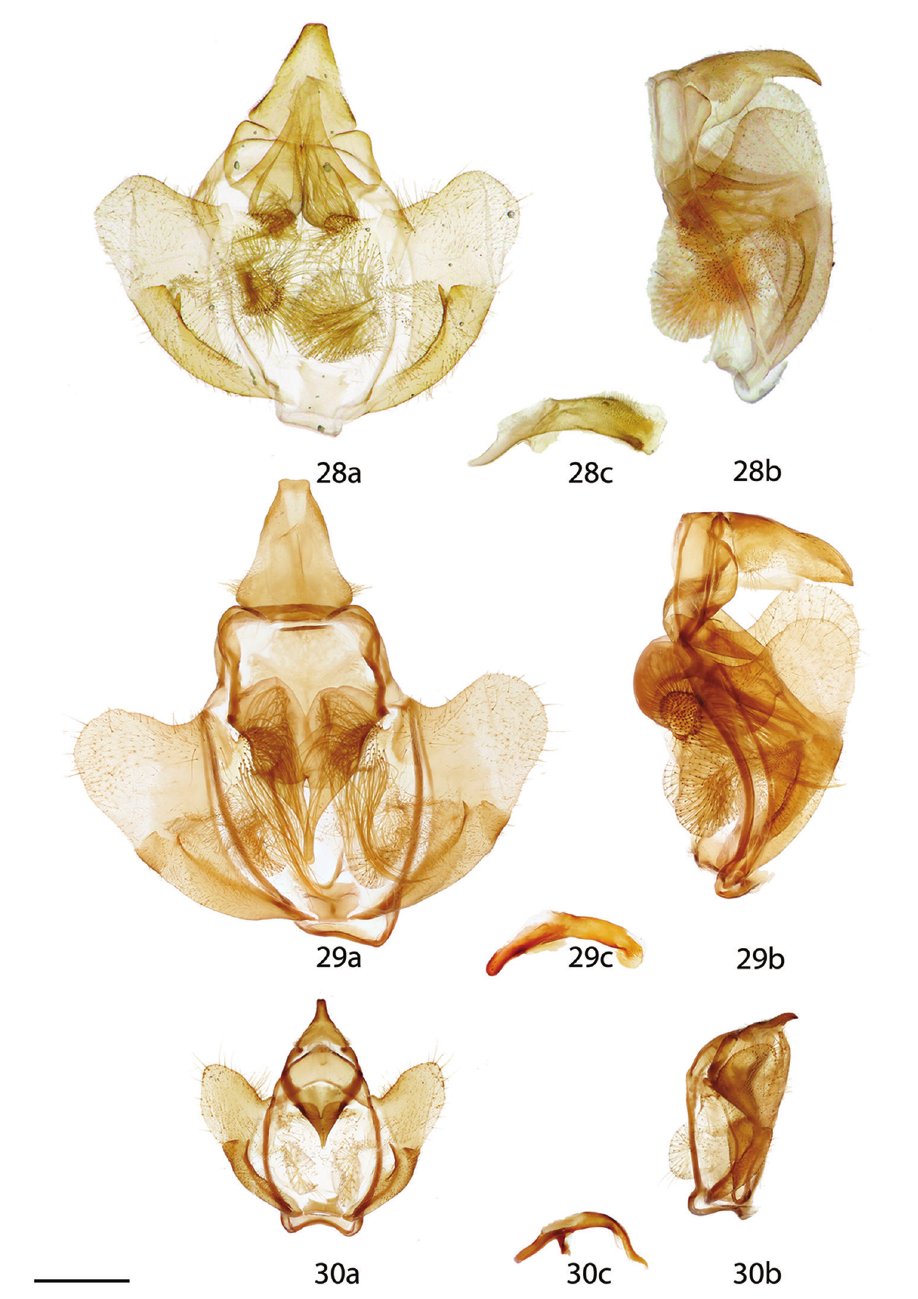
trito Federal, Planaltina, 1000 m, C. Mielke genitalia prep. 6.812 (CPAC) 29 R. minasa , Brazil, Espírito Santo, St Laurent diss.: 5-15-16:1 (CUIC) 30 R. ignea Paratype, Brazil, Santa Catarina, São Bento do Sul, Rio Vermelho, 968 m, St Laurent diss.: 5-6-16:1 (ISEZ). Scale bar: 1